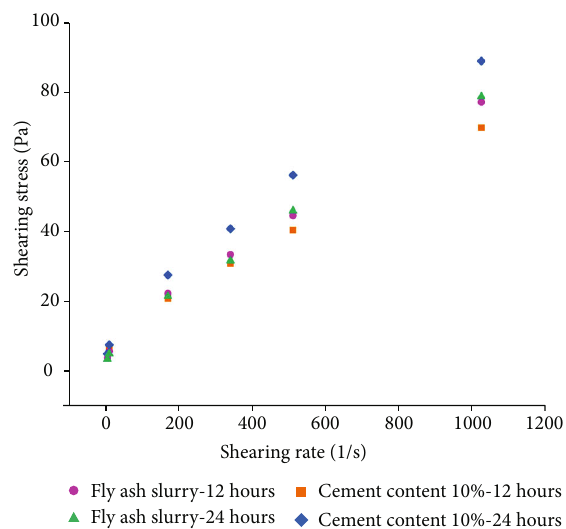
Figure 5: Fly ash, modi fi ed fl y ash slurry (water-ash ratio of 1.2) plastic